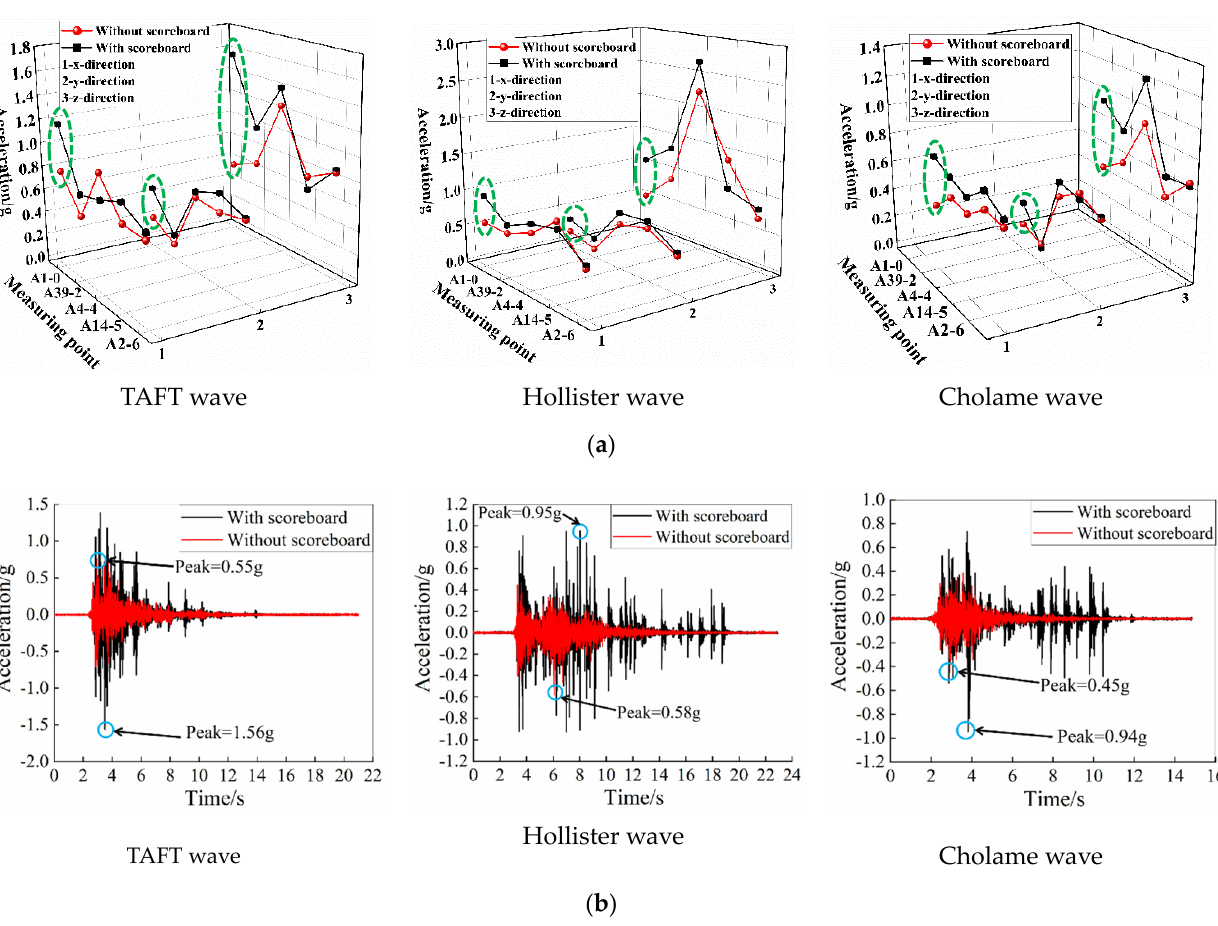
Figure 13. Acceleration response comparison: ( a ) Peak acceleration; ( b ) Acceleration time-history curves of measuring point A1 − 0 in the z − direction. Table 8. Comparison of acceleration amplification coefficient.